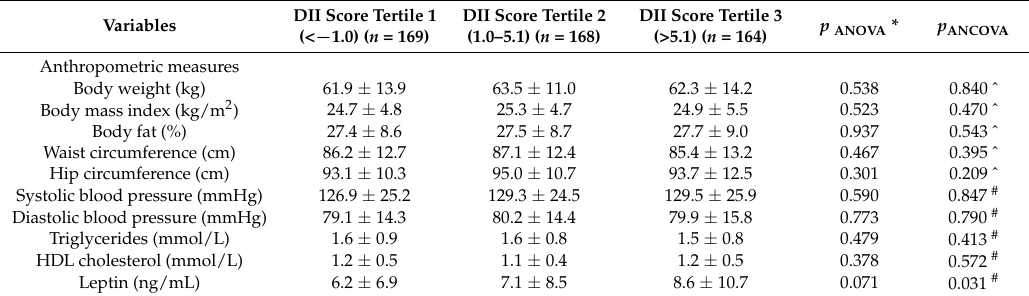
Table 4. The differences on anthropometric measures, lipid profile, blood pressure and leptin among DII score